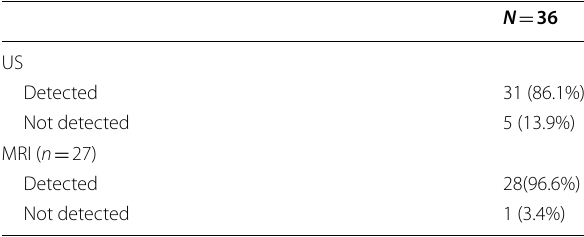
Table 2 Postnatal imaging or autopsy